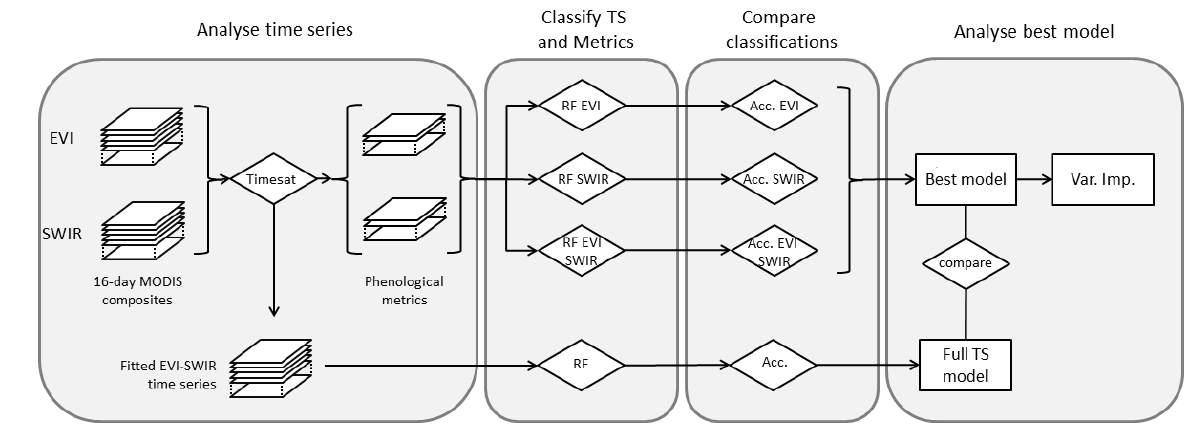
Figure 2. Processing scheme showing the comparison of the models based on phenological metrics to each other and to the full time series model. RF: random forest classification; Acc.: accuracy assessment; TS: time series; Var. Imp.: variable